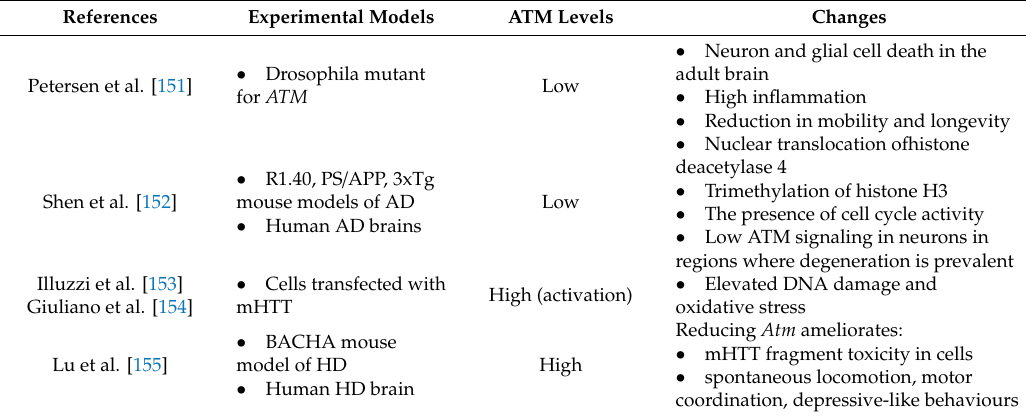
Table 1. Alteration of ataxia-telangiectasia mutated (ATM) expression levels in neurological conditions beyond